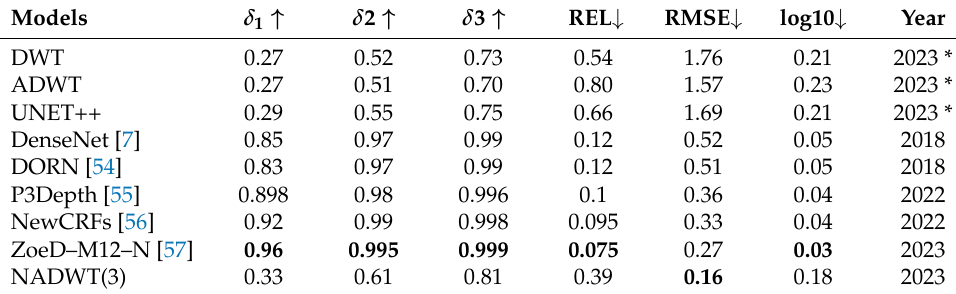
Table 3. Comparison of model